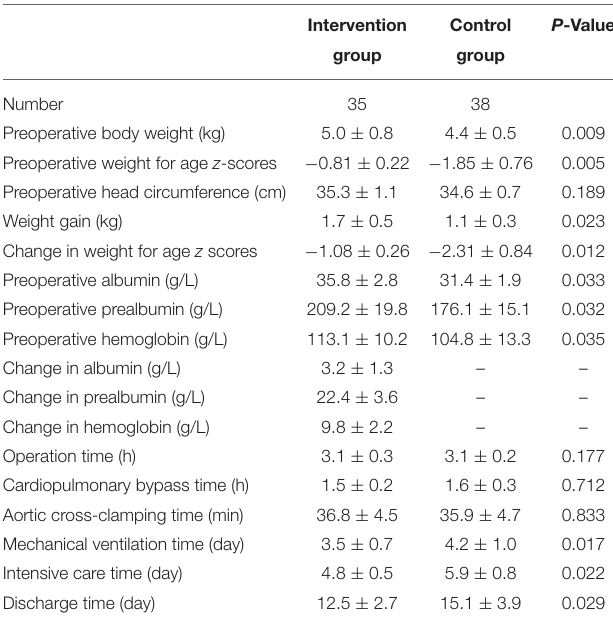
TABLE 2 | Comparison of the perioperative data between the two groups [mean ± SD or (%)].